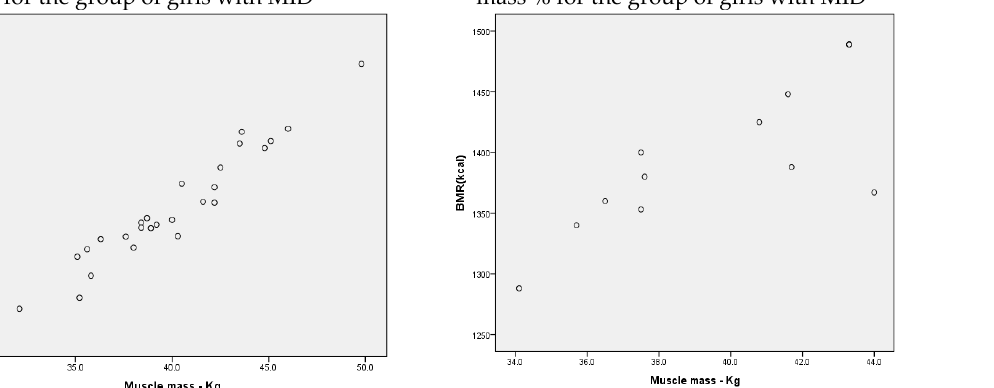
Graph 3. Correlation between BMI and body fat % for the group of girls with MID